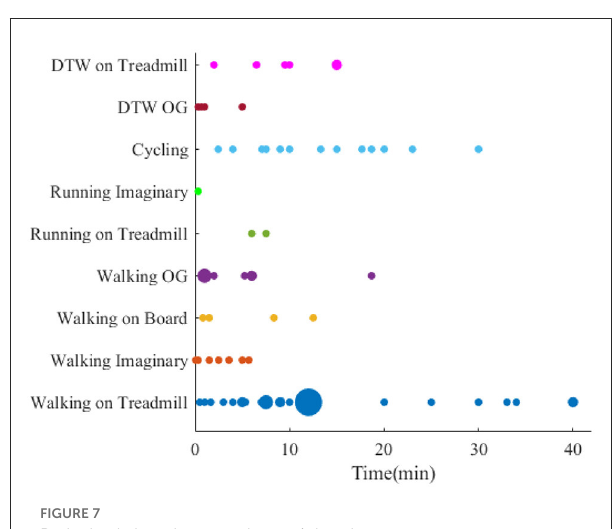
FIGURE7 Brain-body imaging experiments’